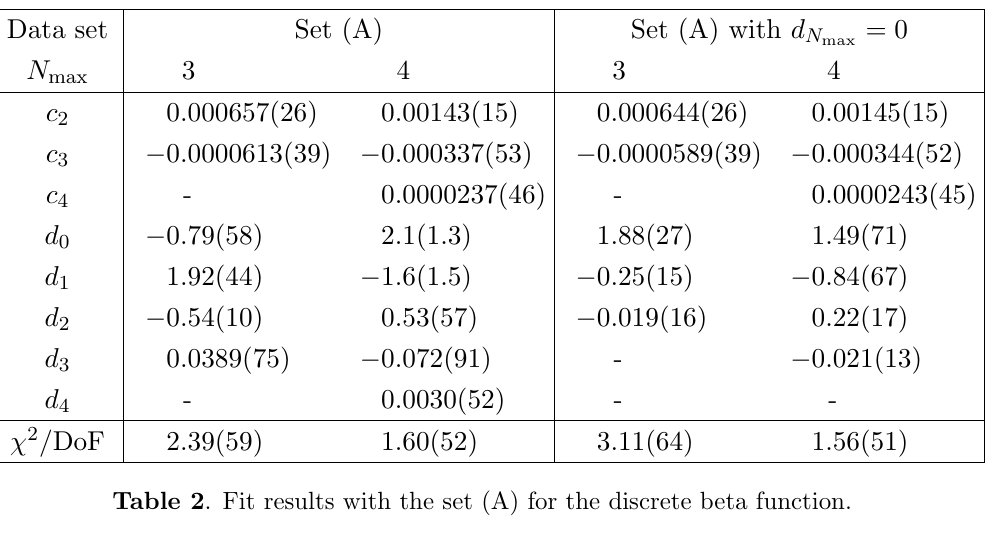
table 1. This corresponds to u max ’ 6 :